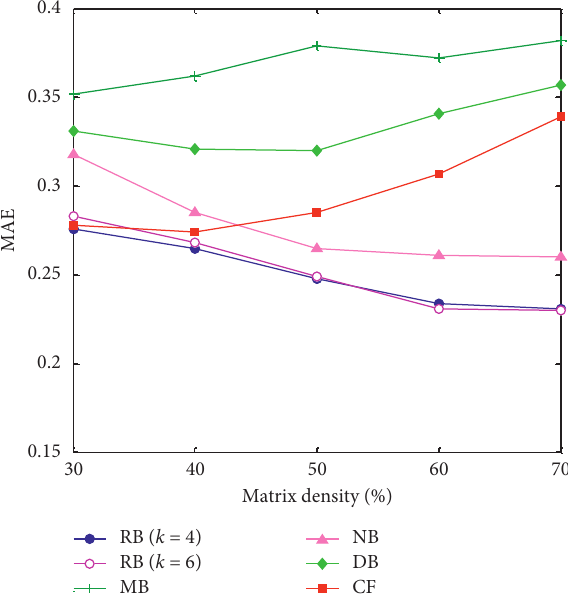
Figure 4: MAE for different matrix densities (30%–70%).